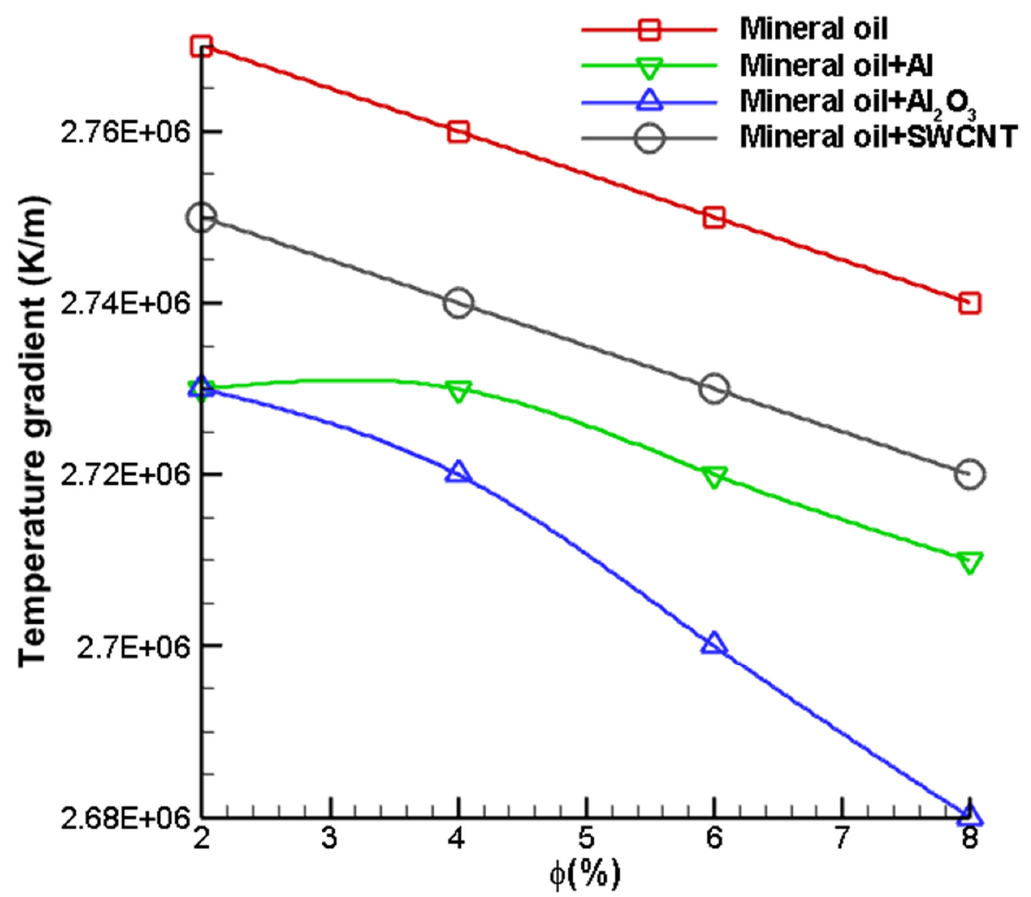
Figure 12 . Variation in the temperature gradient on the cutting tool with different volume frac ‐ tions of dispersed nanoparticles. of dispersed